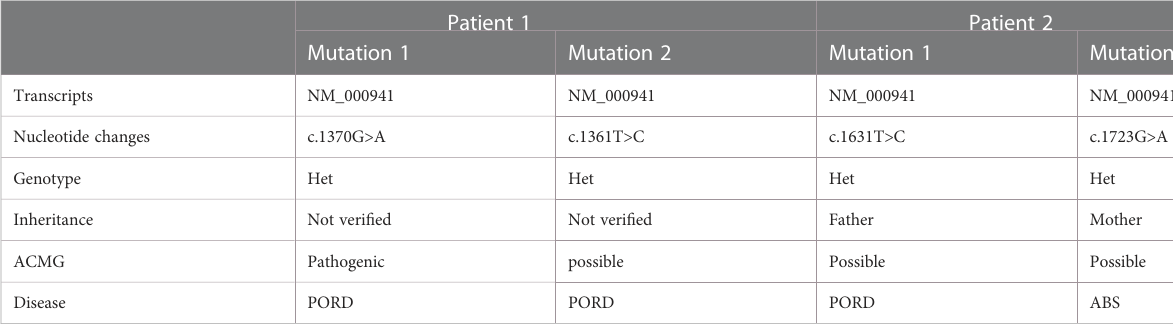
TABLE 2 Summary of genetic molecular analyses.